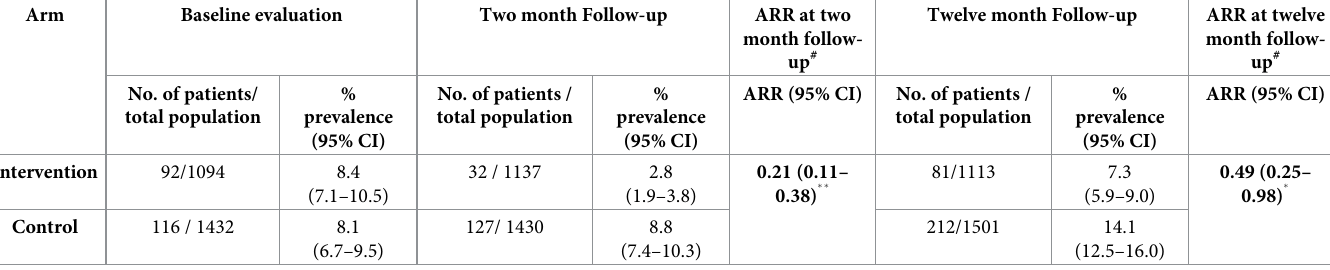
Table 2. Prevalence of scabies at the baseline, at two and twelve month follow-up evaluation in the two arms of the study. Arm